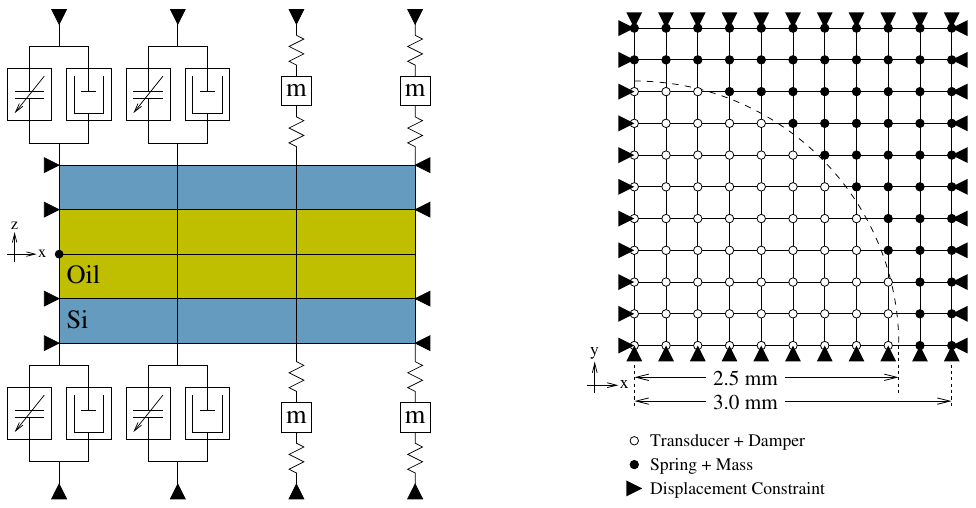
Figure A1. Side view (with reduced element count) and top view of FEA